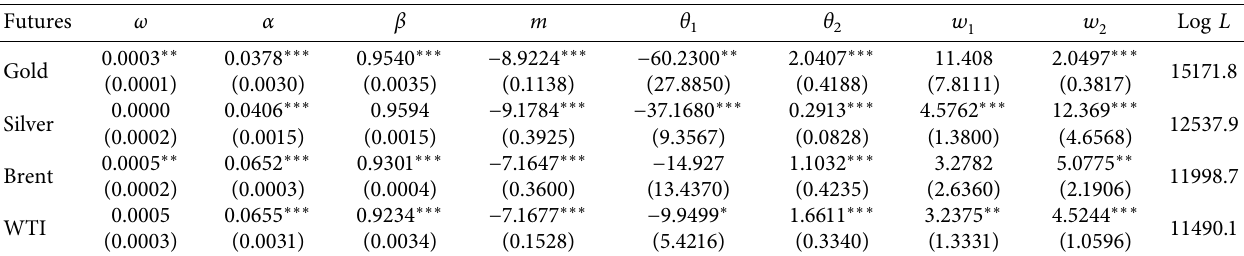
Table 9: Estimation results of GARCH-MIDAS +RV +ID-EMV models of futures volatility by infectious disease with 12-month lags.